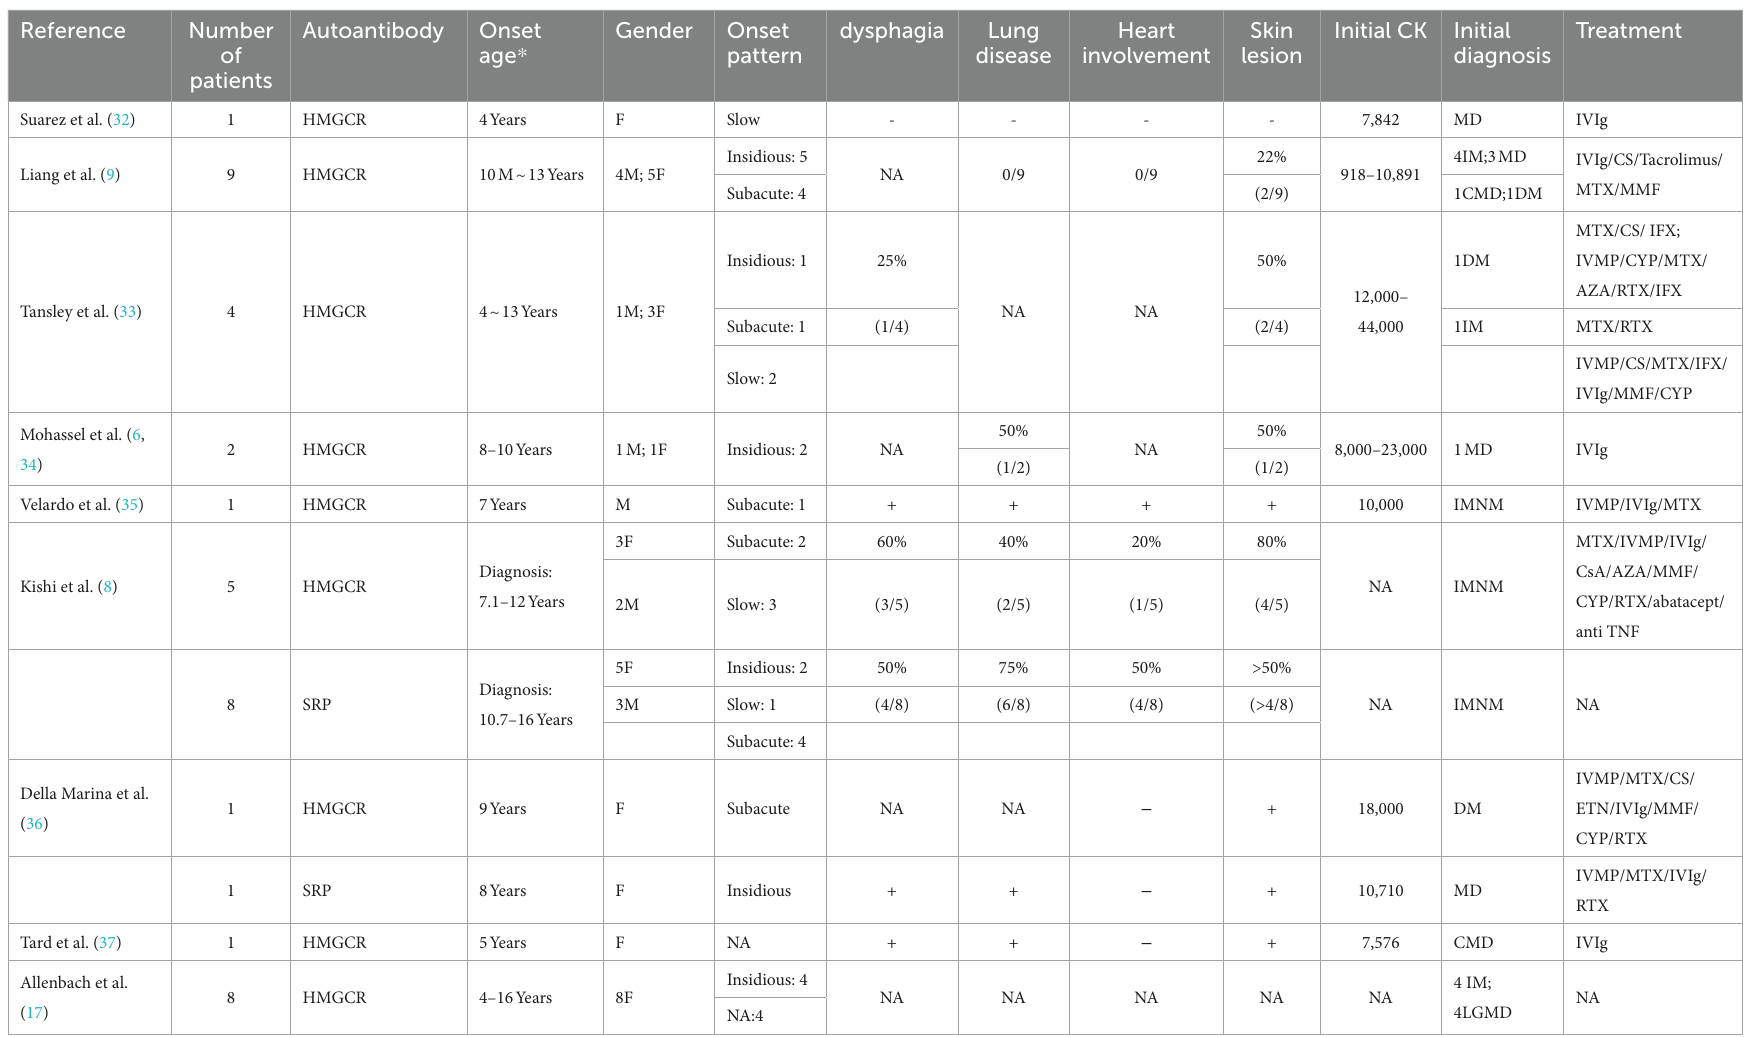
TABLE 1 Clinical characteristics of pediatric